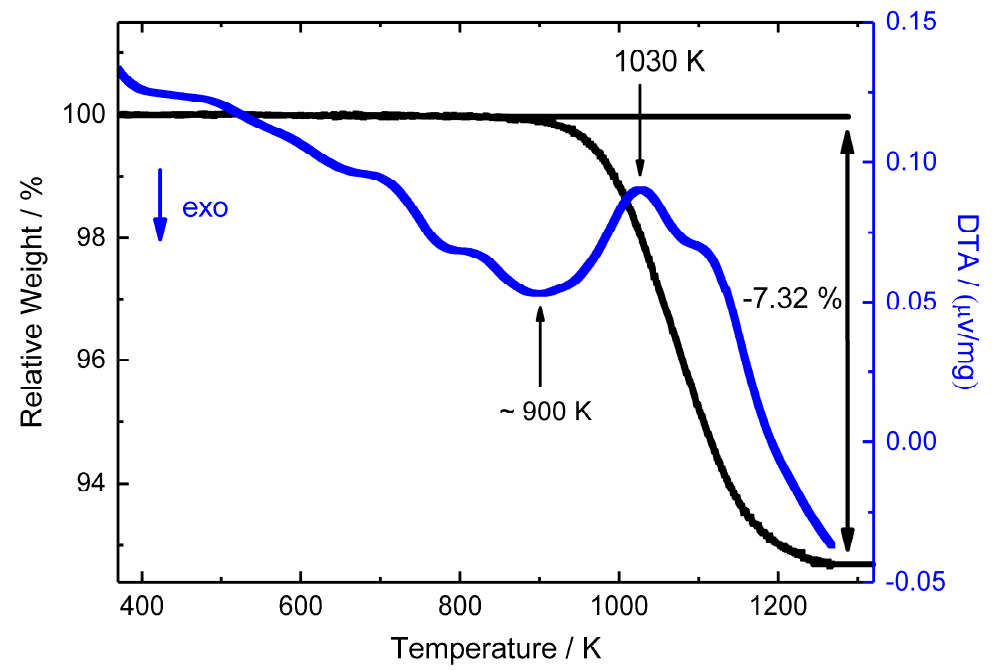
Figure 4. TG-DTA data of ε -Fe 2 MnN. The endothermic effect at about 900 K (onset) is attributed to the decomposition into a (Fe, Mn):N alloy. The mass loss of 7.32 wt% up to 1270 K is in accordance with the calculated nitrogen content in ε -Fe 2 MnN (7.75 wt%).